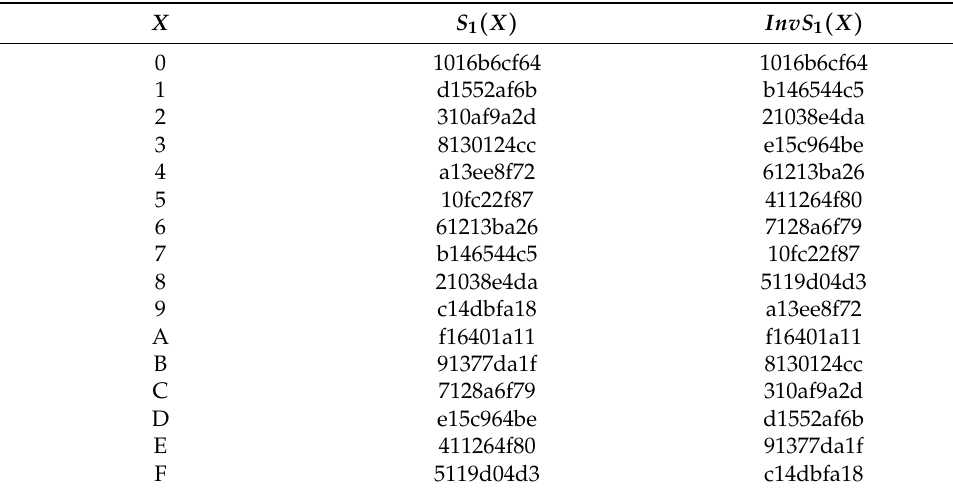
Table 11. New generated 32-bit output S-Box to replace Table 2.